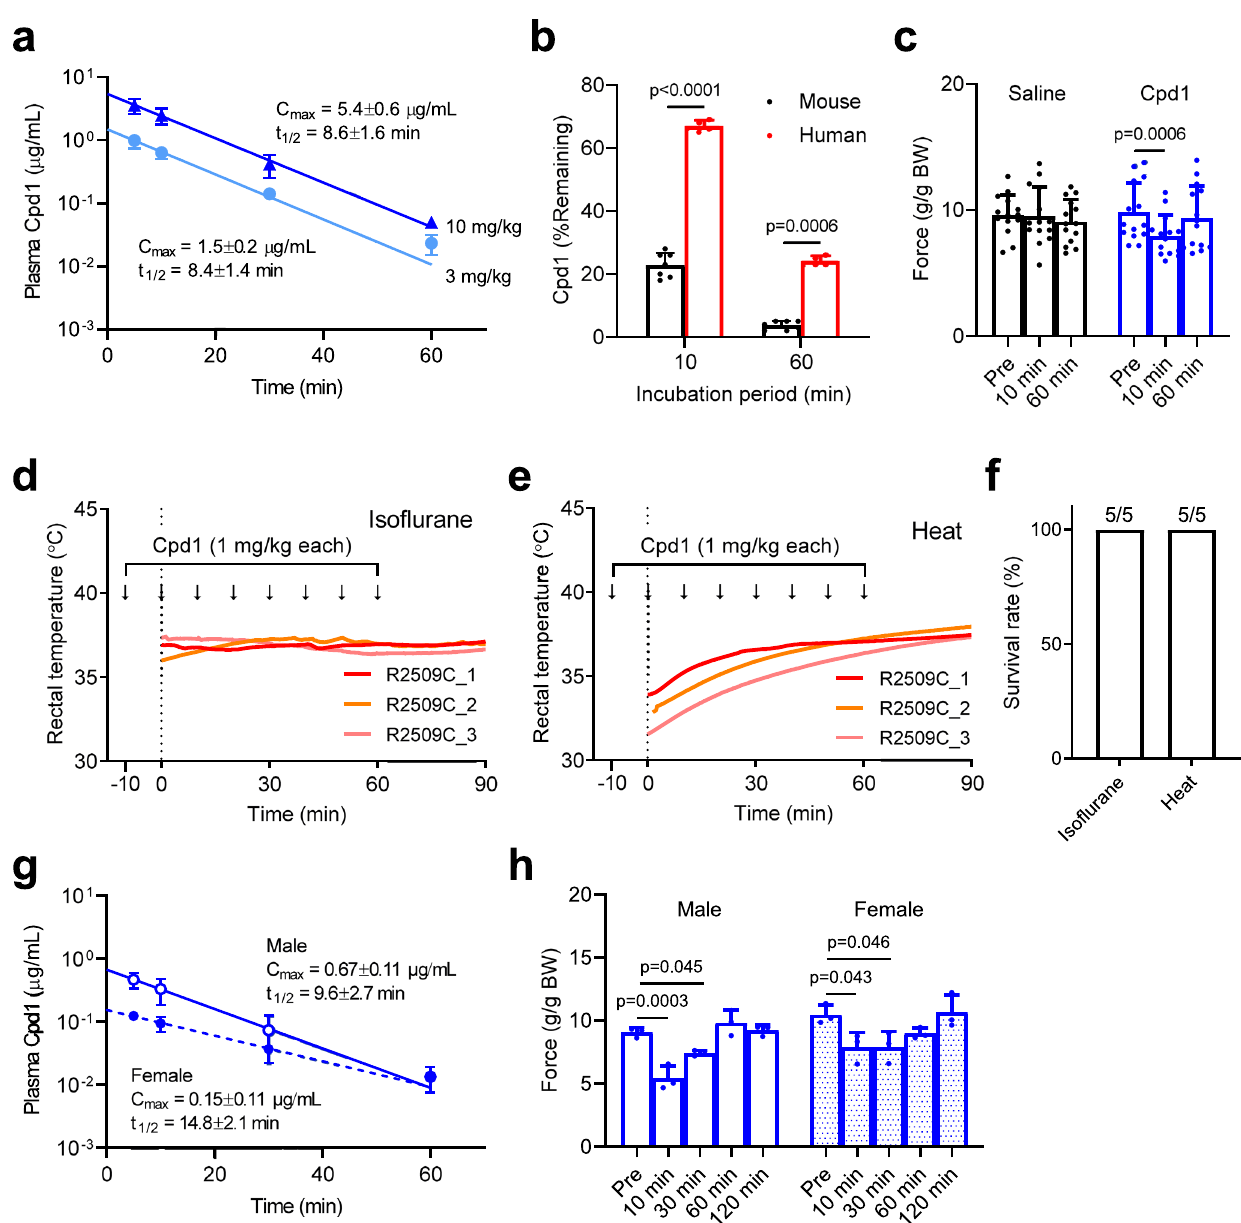
Fig. 6 Pharmacokinetics of Cpd1 in mice. a Averaged plasma concentration – time pro fi les of Cpd1 following i.p. injection of 3 mg/kg and 10 mg/kg. Data are means ± SD ( n = 6 per time point in each group). b Metabolic stability of Cpd1 in the presence of mouse or human liver microsomes. Residual rates of Cpd1 at 0 min were considered 100%. Data are means± SD (mouse: n = 7; human; n = 4) and were analyzed by two-tailed unpaired t- test. c Effect of Cpd1 on muscle force of WT mice in vivo. Muscle force was measured by grip force test (4-grips test). The tests were performed before (pre) and 10 and 60 min after i.p. injection of saline ( n = 14) or Cpd1 ( n = 14). The force values were normalized by body weight (BW). Data are shown as means ± SD and were analyzed by one-way ANOVA with Tukey ’ s test. d – f Effect of repeated administration of Cpd1 on rectal temperature of R2509C mice stimulated by iso fl urane ( d ) or environmental heat stress ( e ). Cpd1 was i.p. injected 8 times at 1 mg/kg every 10 min and stimulus (iso fl urane or environmental heat) was started at time 0. f Survival rate of mice 90 min after iso fl urane or heat stress challenge. All the mice survived. g Averaged plasma concentration – time pro fi les of Cpd1 following 8-times injection of 1 mg/kg at 10 min intervals in male and female mice. Data are shown as means ± SD ( n = 3 per time point). h Effect of Cpd1 on muscle force of male ( n = 3) and female ( n = 3) WT mice in vivo following 8-times injection of 1 mg/kg at 10 min intervals. Data are shown as means ± SD and were analyzed by one-way ANOVA with Tukey ’ s test. Source data are provided as a Source Data fi